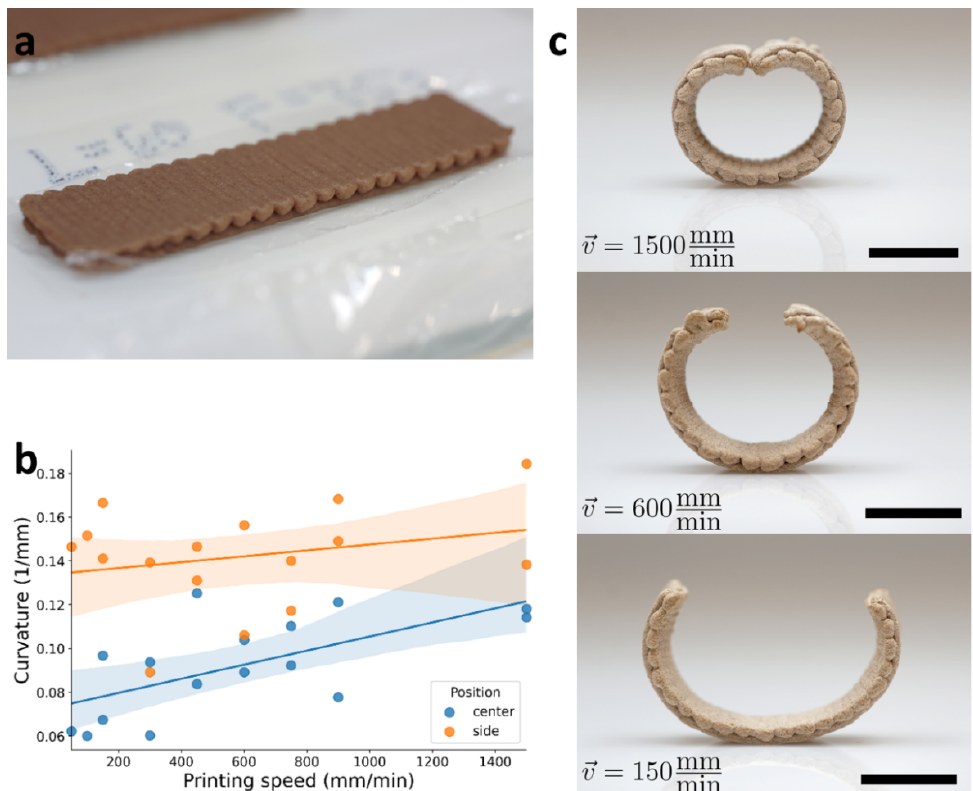
Figure 3. 90° oriented bilayers. ( a ) printed object “as printed”, wet length = 60 mm, wet width = 15 mm. ( b ) Curvature as a function of printing speed measured at two different locations: center and side, blue and orange markers, respectively. ( c ) Dried 3D warped objects at different velocities, scale bar indicates 10 mm, demonstrating an increased effect at higher velocities.